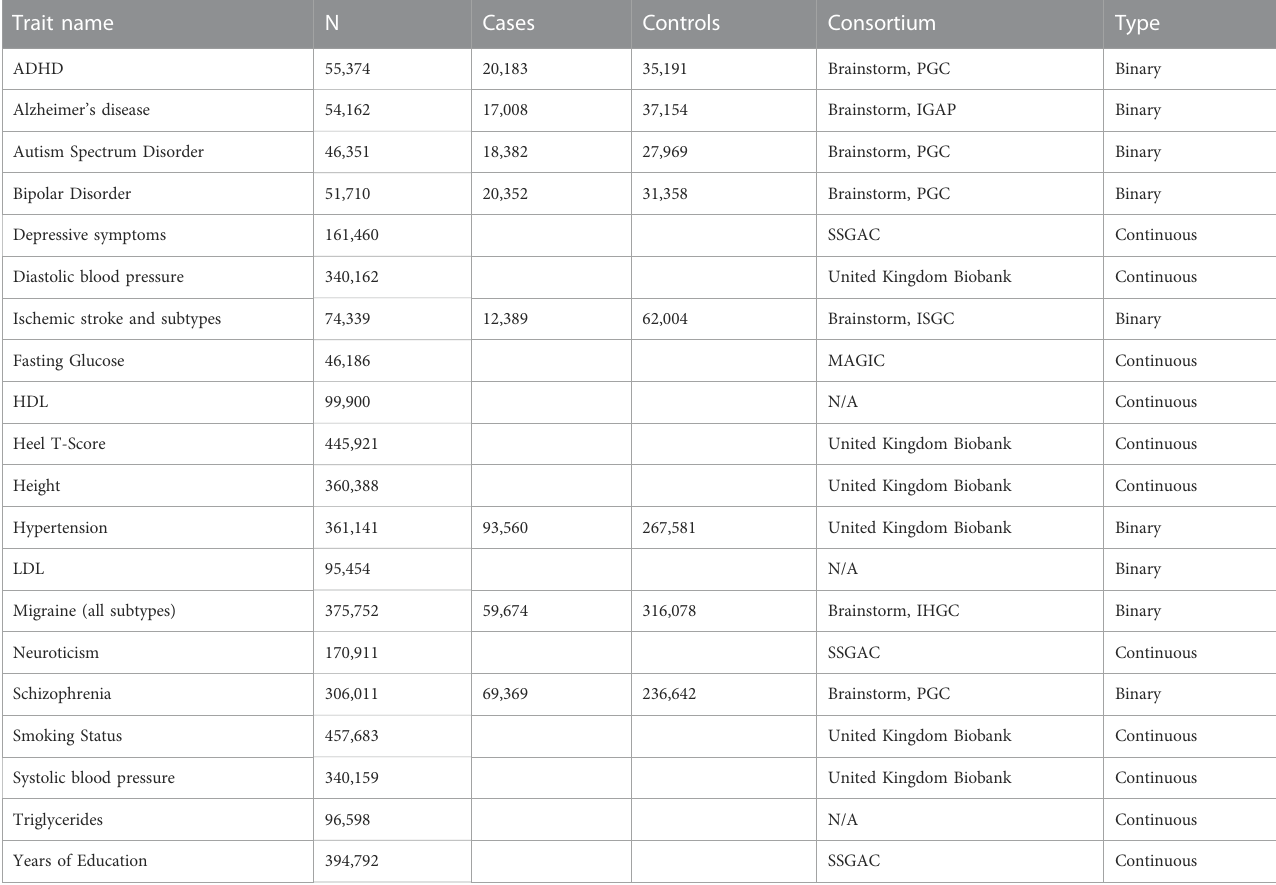
TABLE 2 Detail of all GWASs used as the test